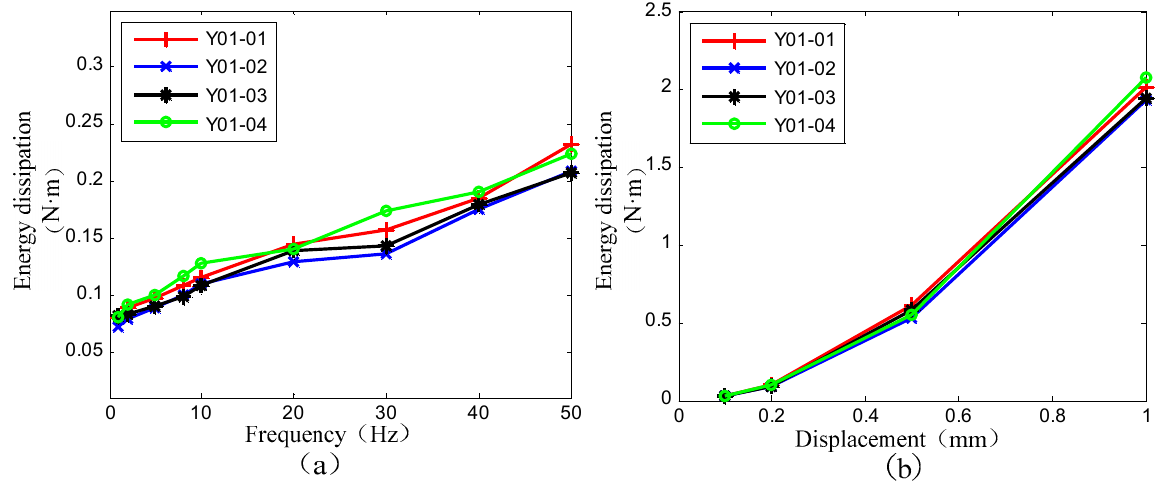
Figure 15. Energy dissipation of specimens Y01 ‐ 01~04 vary with ( a ) frequency at 0.2 mm and ( b ) displacement at 5 Hz.